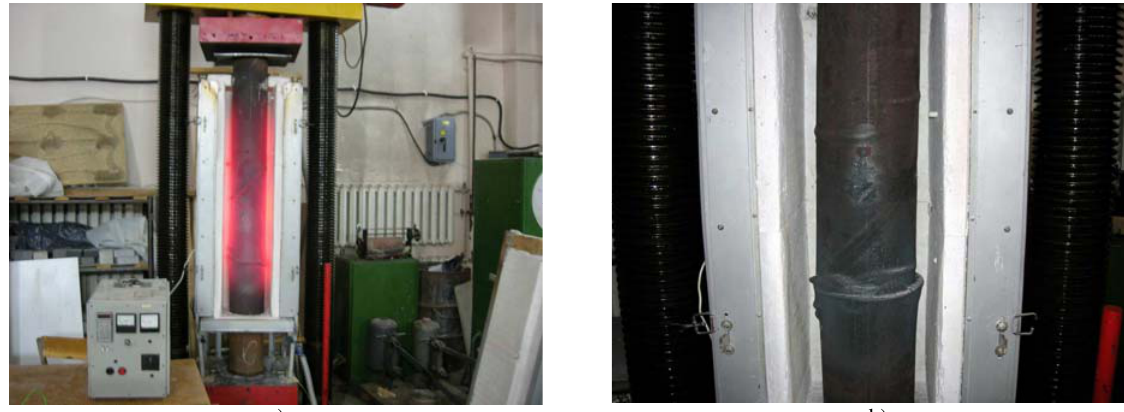
Fig 8 . A specimen during the test of Type 2: a) HC-FST specimen during the test; b) HC-FST specimen after